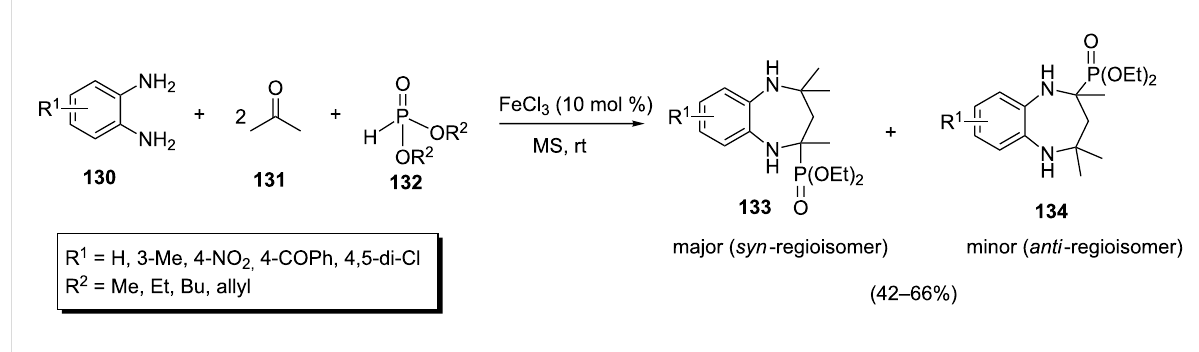
Scheme 28: FeCl 3 -catalyzed four-component reaction for the synthesis of 1,5-benzodiazepin-2-ylphosphonates.